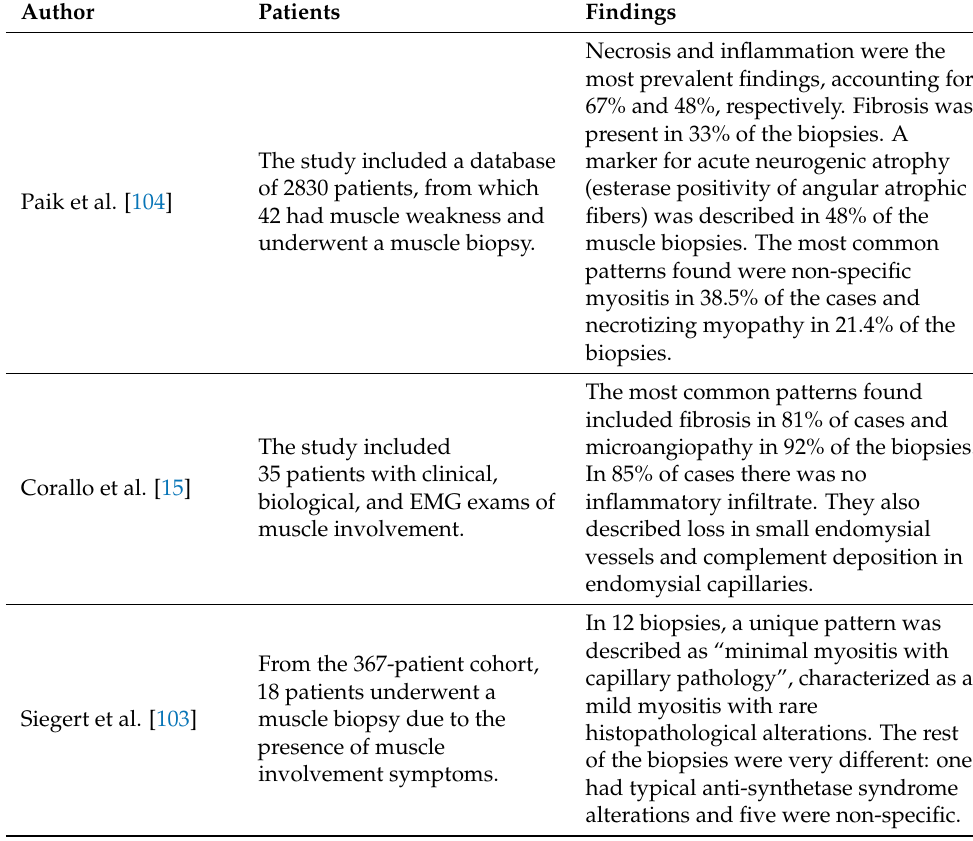
Table 3. Muscle biopsy patterns reported in patients with SSc and muscle involvement